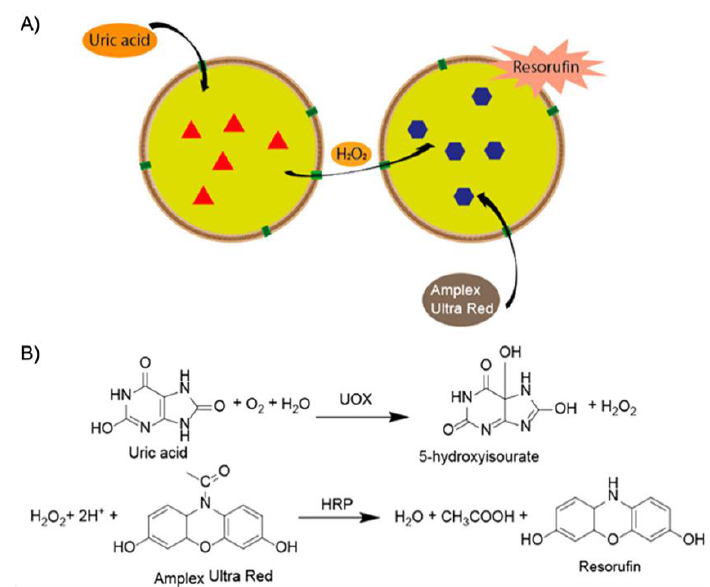
Figure 19. Enzymatic cascade reaction in PMOXA- b -PDMS- b -PMOXA polymersomes. ( A ) Schematic illustration of the biocatalytic cycle. ( B ) Two-step reaction of uric acid to H 2 O 2 and subsequently to water catalyzed by UOX and HRP. Reproduced with permission of [150]. Copyright 2014 American Chemical Society.